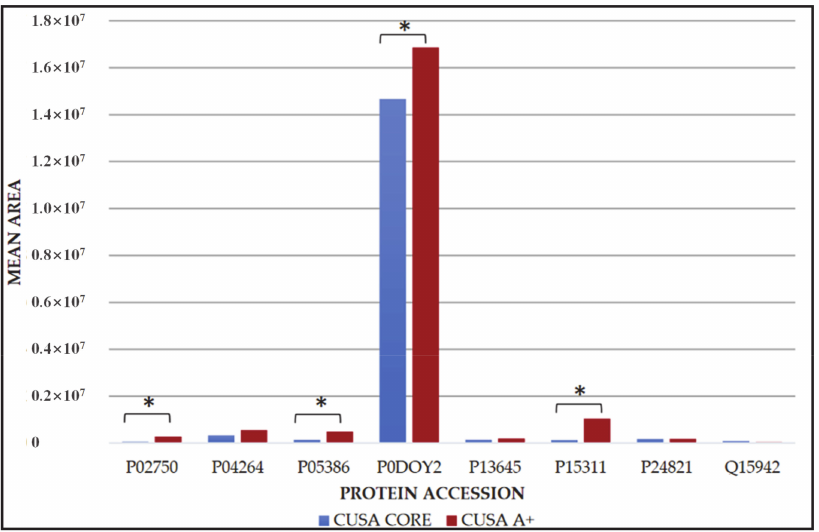
Figure 4. Bar chart representing the mean area with their corresponding standard deviations of leucine-rich alpha-2 glycoprotein (P02750), keratin, type II cytoskeletal 1 (P04264), 60s acidic riboso- mal protein P1 (P05386), immunoglobulin lambda constant 2 (P0DOY2), keratin, type I cytoskeletal 10 (P13645), ezrin (P15311), tenascin (P24821) and zyxin (Q15942) proteins common to CUSA core and CUSA A+., The proteins with statistically significant differences of the mean area values in the two zones are marked. (*, p value <